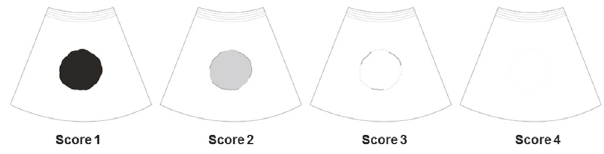
Figure 1: A schema showing the conspicuity